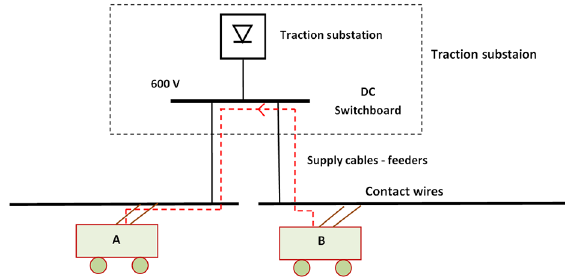
Fig. 6. Regenerative braking energy flow in case of vehicles on different power supply sections of the same traction